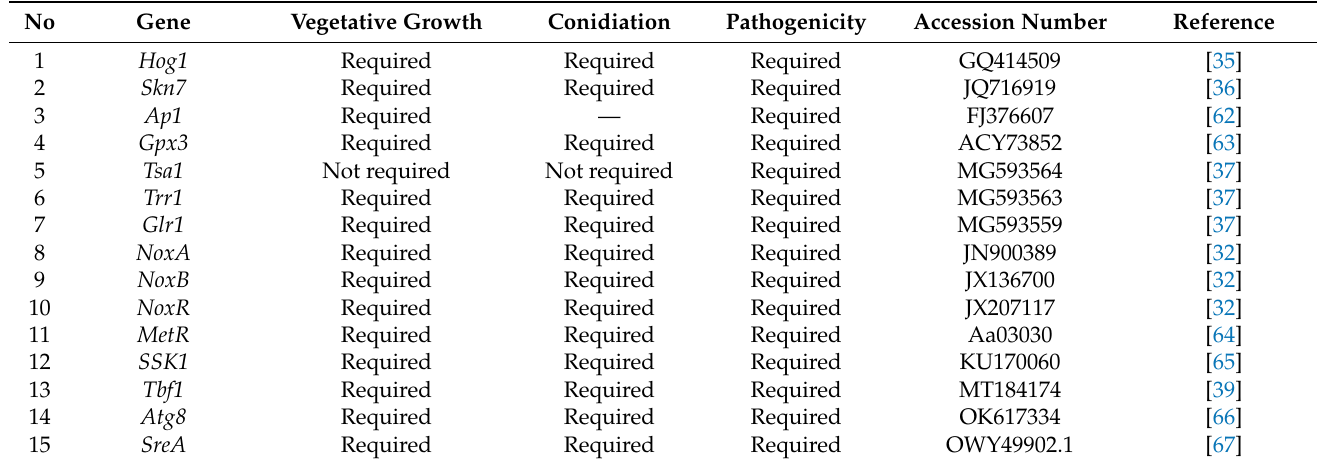
Table 4. ROS detoxification-related genes in A. alternata tangerine